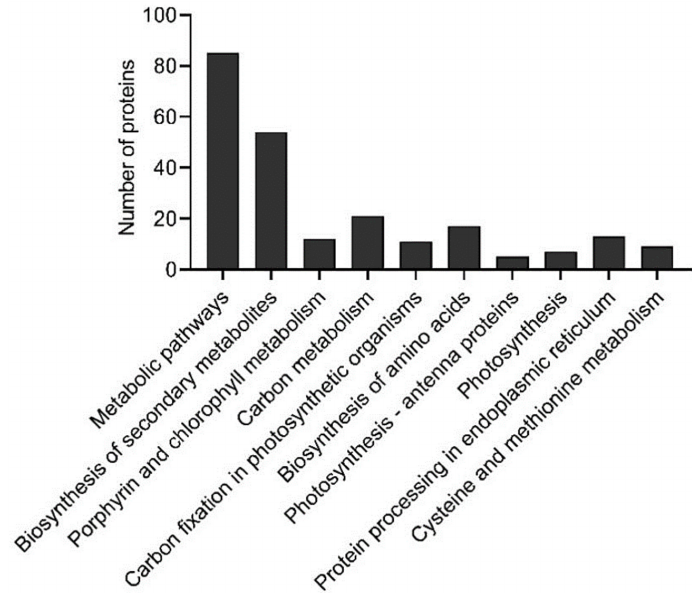
Figure 3. The most enriched KEGG pathways (corrected p value < 0.0005) related to di ff erentially abundant proteins in banana ( Musa spp. AAA) after exposure to 10 ◦